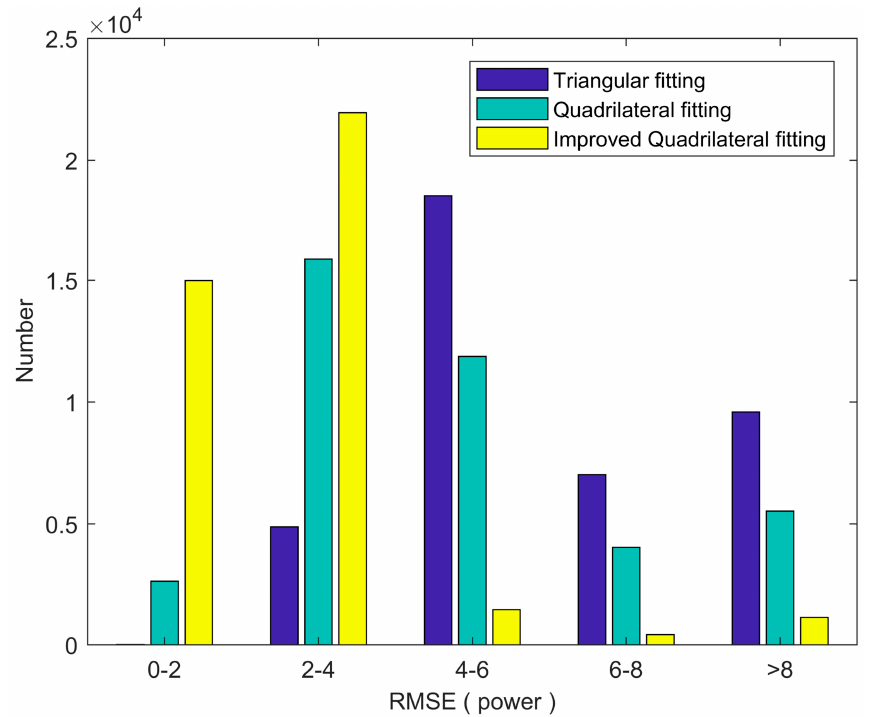
Figure 8. The RMSE distribution of the detected waveform numbers for the three algorithms.